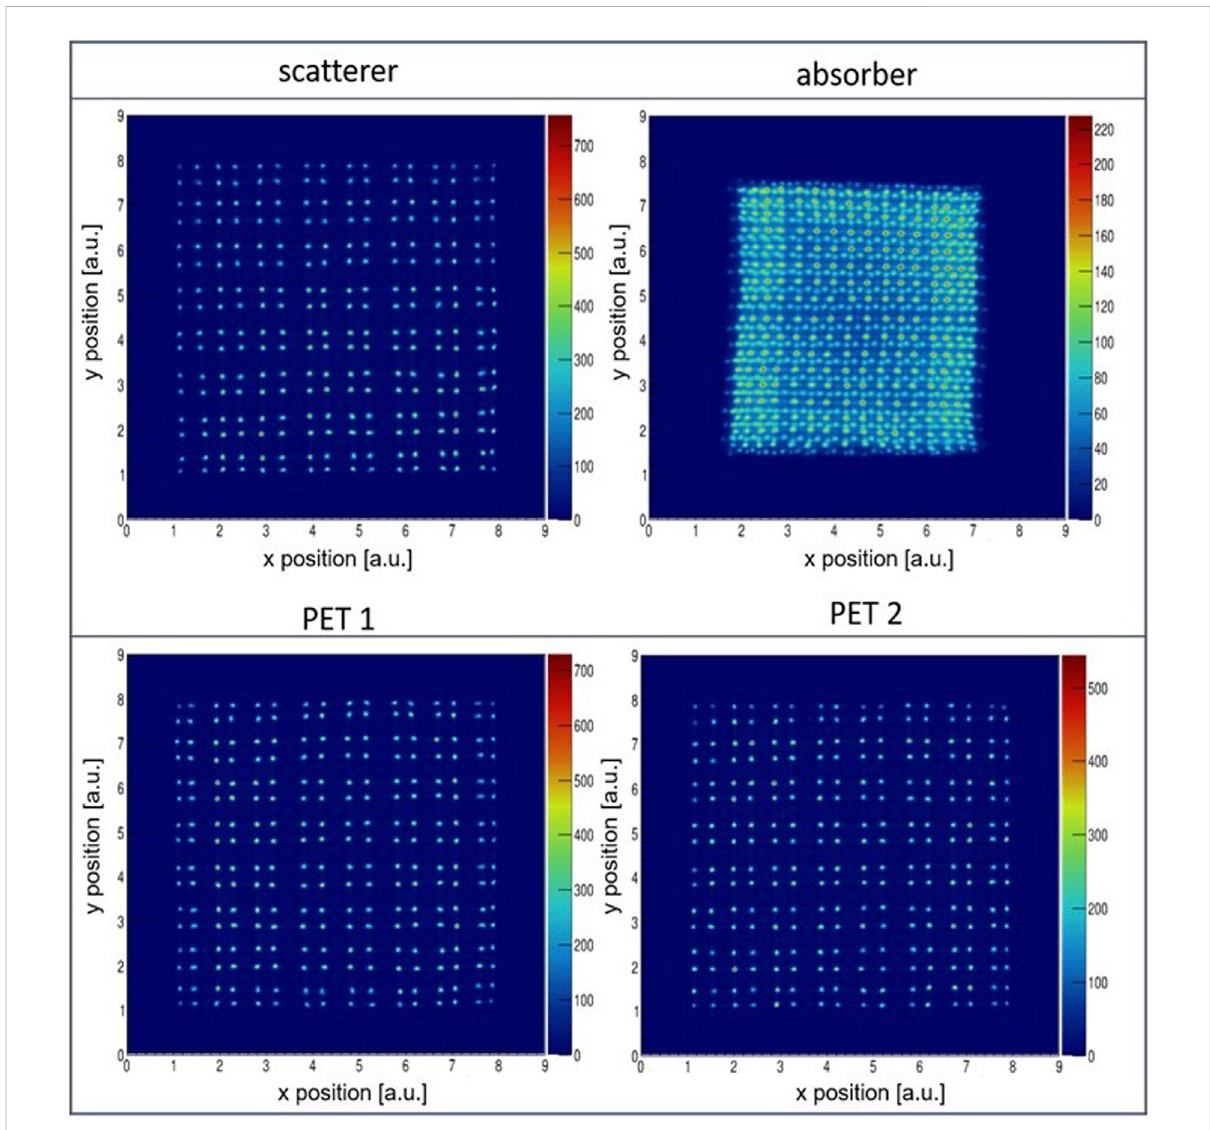
FIGURE 3 Flood maps obtained from the four detectors of the γ -PET prototype acquired using an irradiation with a 137 Cs point source (662